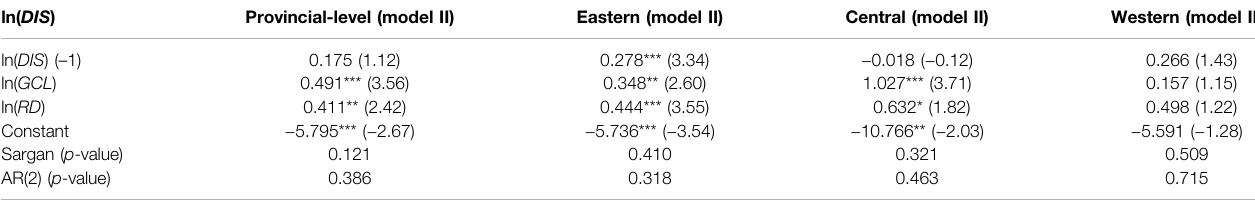
TABLE 3 | Results of system GMM on effects of green credit on disruptive low-carbon innovation. ln( DIS